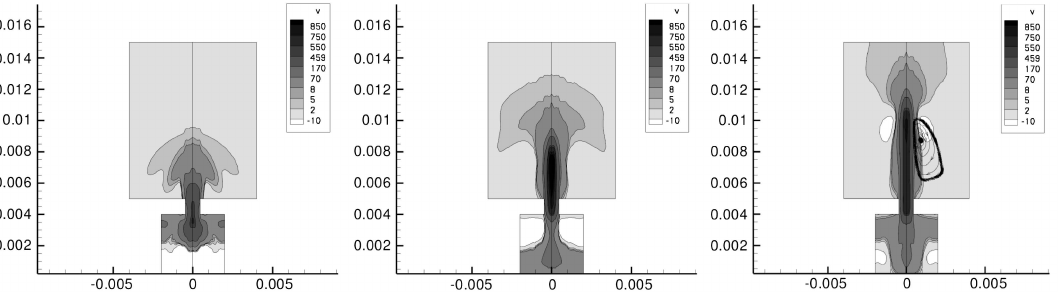
Figure 8. Velocity distribution in the jet at ( left ) 12, ( middle ) 25, ( right ) 37 µ s after the breakdown